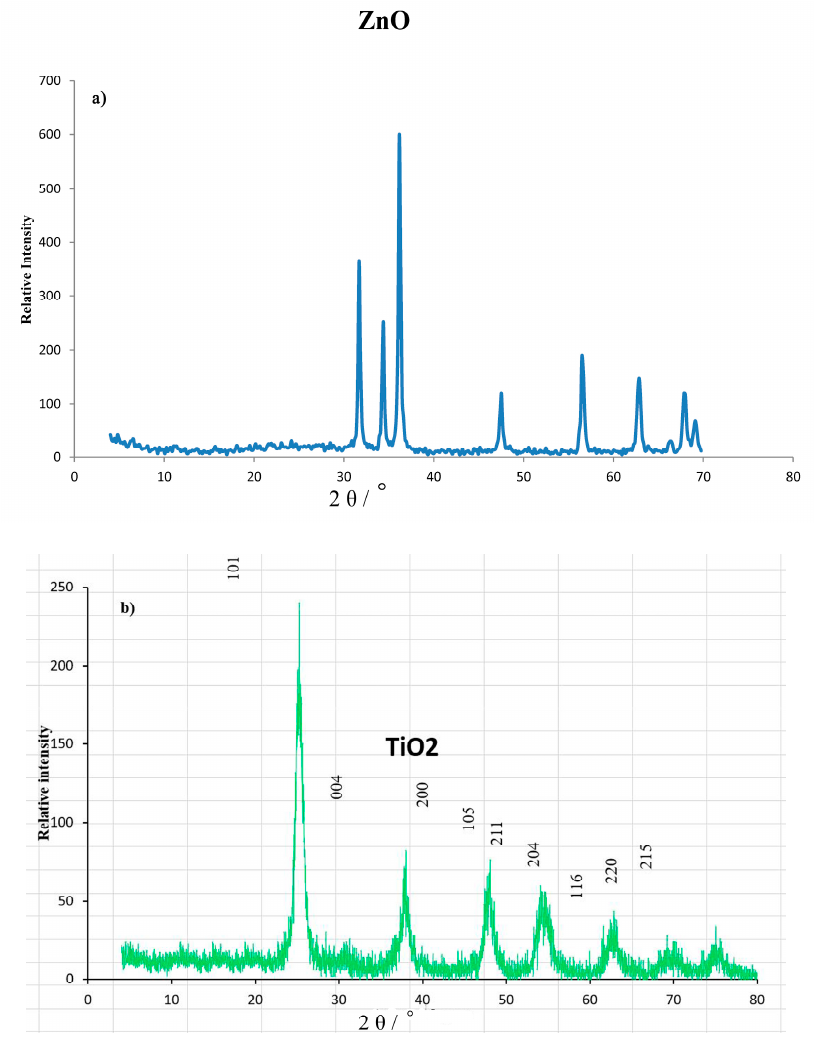
Figure 2. XRD patterns: ( a ) ZnO and ( b ) TiO 2 nanopowders.